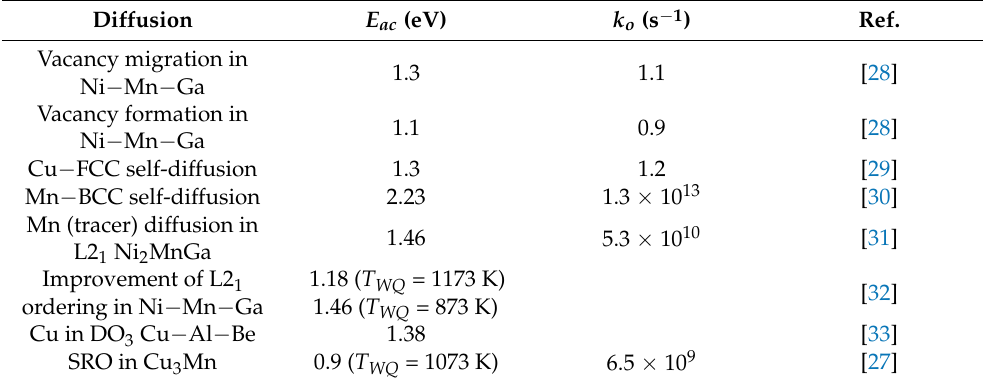
Table 2. Activation energy and pre-exponential factors collected from the literature for the diffusion of Cu and Mn in different